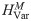
Influence of the combination of hypotheses HVarM, HVarΦ and HVarσ on the relation between compensation and perceptual boundary shift.Changes implemented for the internal model and the auditory characterization are the same as in Fig 15. They are illustrated in the top left and top middle panels. In addition to the previous simulations where parameters of the sensory characterizations, σSϕ and σAϕ, where both equal, here we implement two additional values of parameters σSϕ, corresponding to greater variance of the somatosensory characterization, and therefore reduced weight of the somatosensory pathway. The three values of σSϕ implemented are 18 (equal weights of sensory pathways), 16 and 14 (smaller weight for the somatosensory pathway) of the distance between neighboring phonemes. The corresponding changes of the somatosensory characterization are illustrated in the top right panel. Darkness of the colors indicates an increase of the weight of the auditory pathway relatively to the somatosensory pathway.